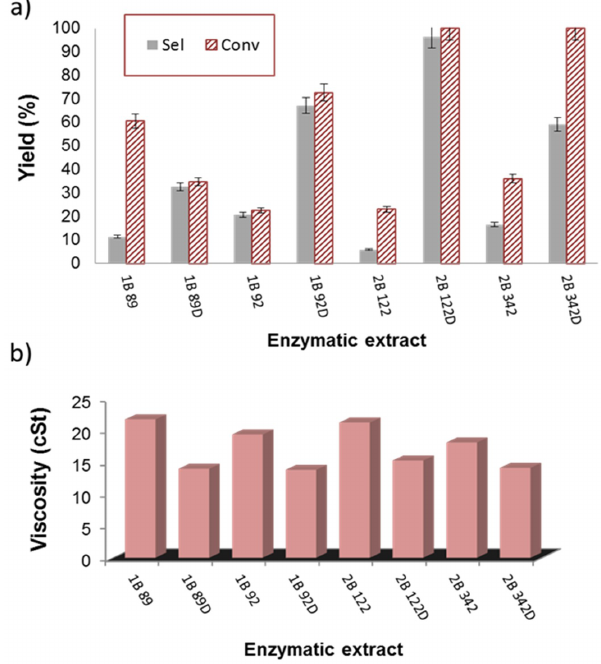
Figure 4. Comparison of the catalytic performance ( a ) and viscosity in cSt ( b ) obtained in the ethanolysis reaction over some cultured microbial wild strains either submitted to the dialysis treatment or not. Table 2. Conversion, selectivity, and viscosity obtained in the enzymatic ethanolysis of sunflower oil under different lyophilized bacterial extracts, with previous dialysis, from vegetable oil (OS) and animal fat (FS) samples. Reaction conditions: 37 ◦ C, 24 h, 300 rpm, operating with 6 mL of oil, 1.75 mL of absolute ethanol, and 0.0125 mL of 10N NaOH solution. Conversion = FAE + DG, being FAE = (FAEE + MG) the selectivity of the process. A minimum of three replicates for each experiment were carried out (less than 6% of error was